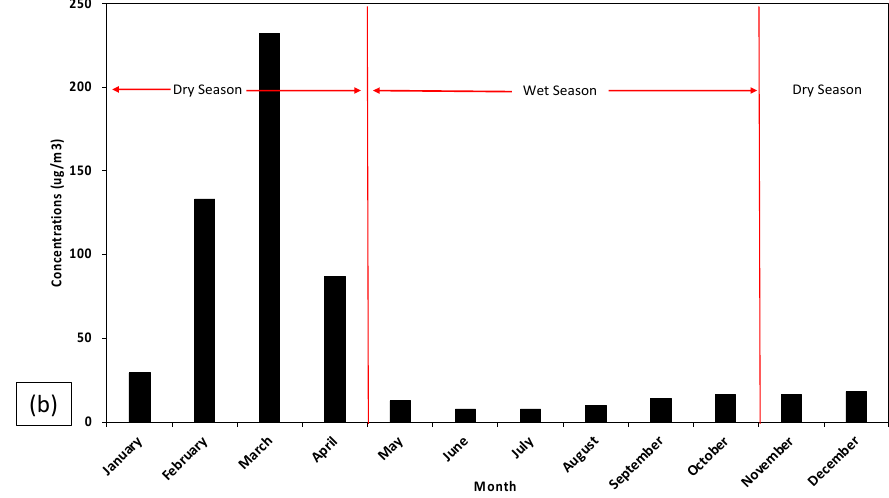
Figure 2. ( a ) Daily and ( b ) monthly means of the PM 2.5 concentrations in northern Thailand during